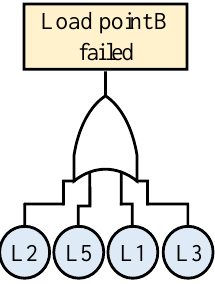
Figure 6. Fault tree of Load B failure.